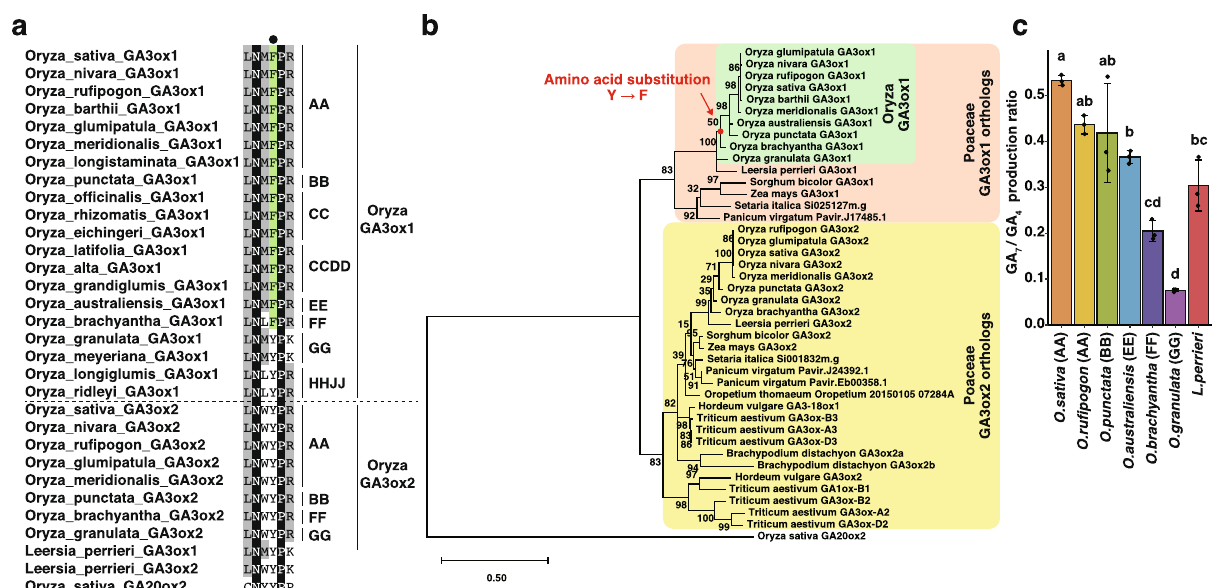
Fig. 3 Residues in the 2OG-interacting site of Poaceae GA3ox orthologs and enzymatic activity of Oryza GA3ox1. a Amino acid sequence alignment in the 2OG-interacting site around F (in OsGA3ox1) of Poaceae GA3ox orthologs and OsGA20ox2. Residues of F in the interacting site of 2OG are indicated in green, those that are 100% identical are shown in black, and those with more than 50% identity are depicted in gray. The black dot indicates the amino acid in the interacting site with co-substrate 2OG, F (shown in green), or Y. On the right side of the alignment, the letters AA and BB indicate the AA and BB Oryza genomes, respectively. b Phylogenetic tree of Poaceae GA3ox orthologs and OsGA20ox2 . The red dot indicates the common ancestor of O. sativa to O. brachyantha that acquired the residue F in the active site. c In vitro enzyme activity of GA3ox1 of Oryza species and L. perrieri ; O. sativa GA3ox1, O. ru fi pogon GA3ox1, O. punctata GA3ox1, O. brachyantha GA3ox1, O. granulata GA3ox1, L. perrieri GA3ox1. Error bars, s.d. n = 3, one-way ANOVA with Tukey ’ s multiple comparisons test. Different letters denote signi fi cant differences ( p < 0.05).